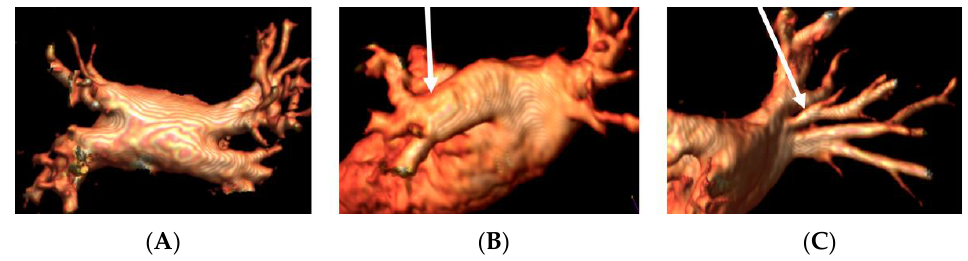
Figure 1. Panel ( A ), normal pulmonary veins anatomy; panel ( B ), left PV common trunk; and panel ( C ), right accessory pulmonary vein.